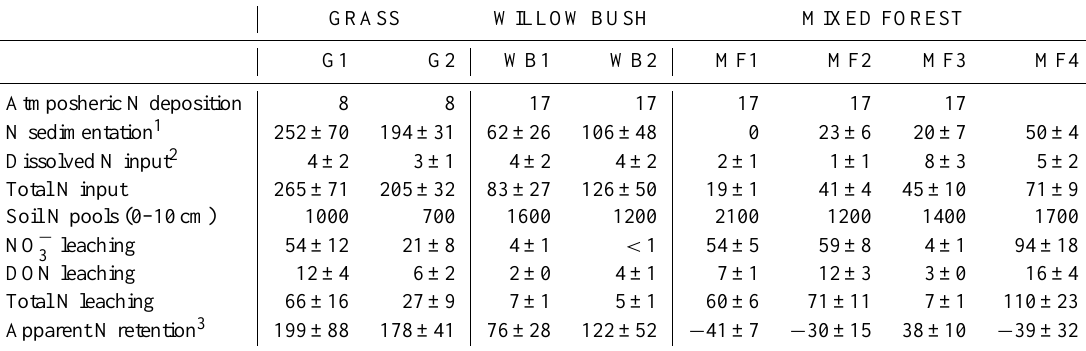
Table 4. Annual N fluxes (±std error) [kgNha − 1 yr − 1 ] for the observation period from April 2009 to March 2010 and soil N pools (±std error) [kgNha − 1 ] of the top